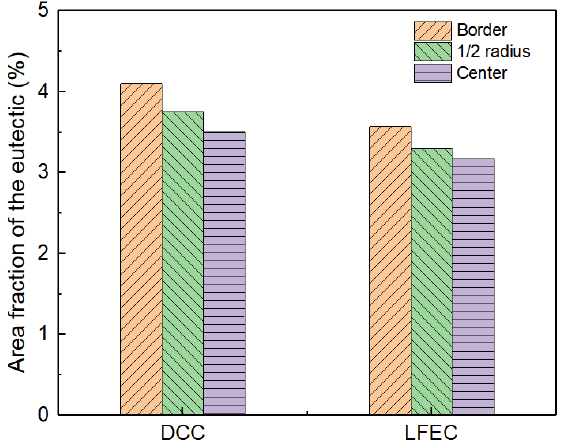
Figure 8. Area fraction of eutectic results of 5A90 as-cast alloy in the SEM images.